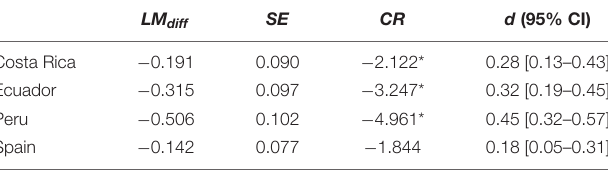
TABLE 5 | Comparisons across reference and comparison